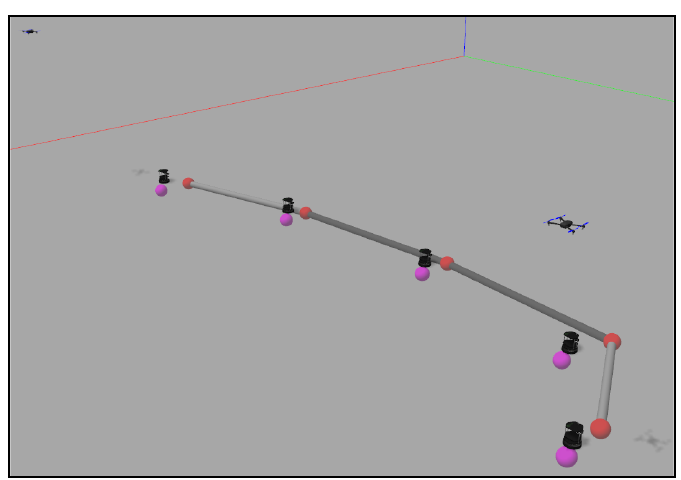
Figure 18. Final layout in an experiment with two targets following crossed trajectories.